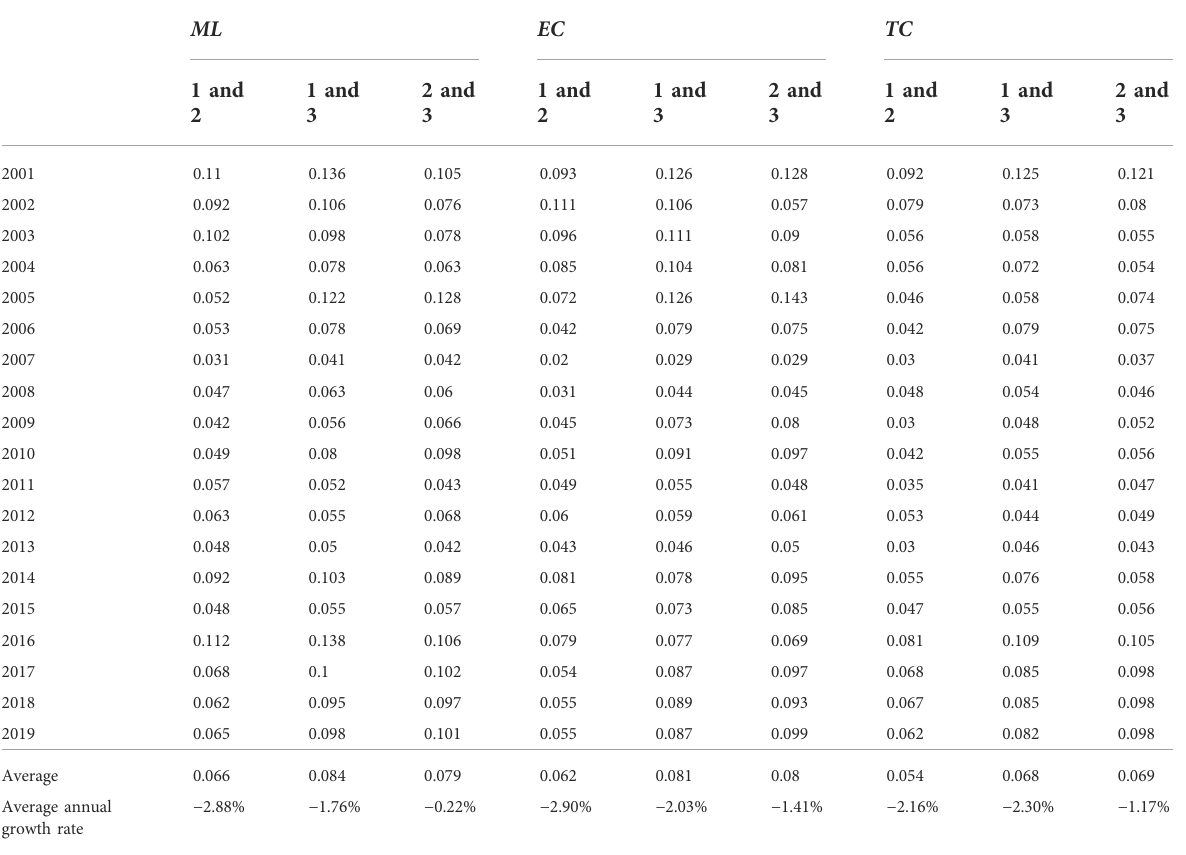
TABLE 4 DCEEIC ’ s difference between regions of ML , EC , and TC